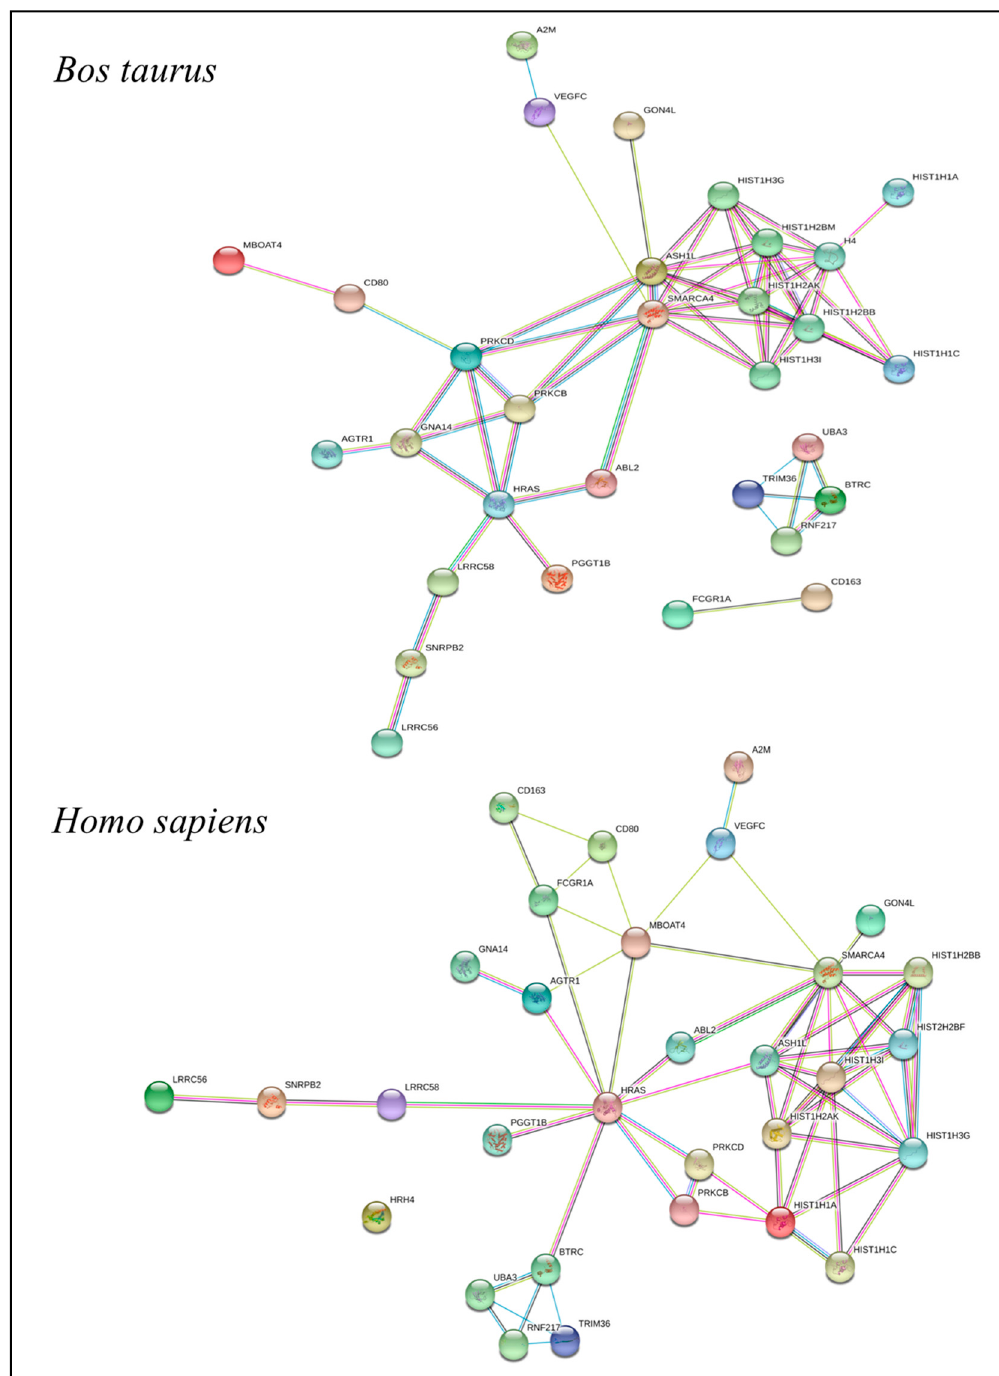
Figure 3. Gene networks in cattle among the ones in QTLRs identified with PFP at 10% (Bovine and Human databases).